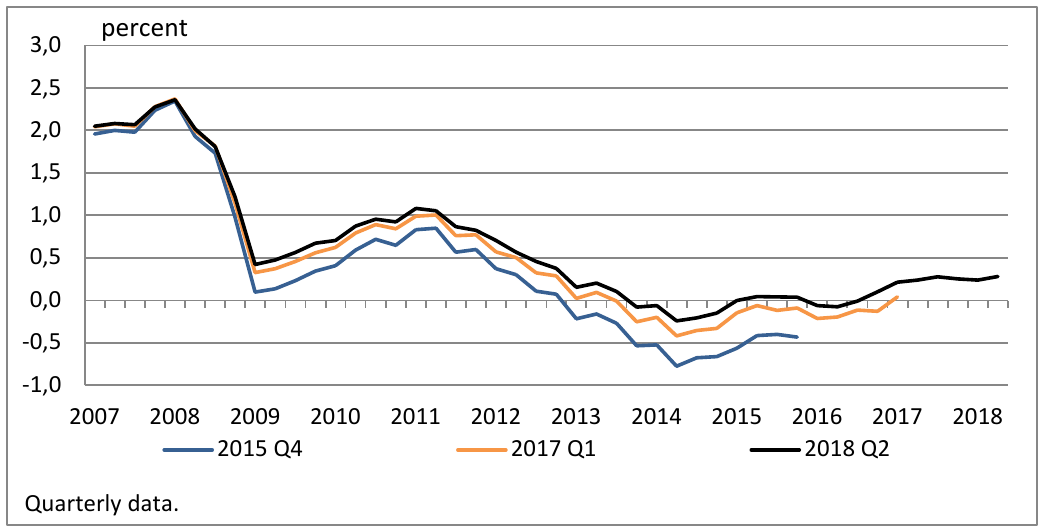
Figure 8: Estimates of the natural interest rate in euro area from different